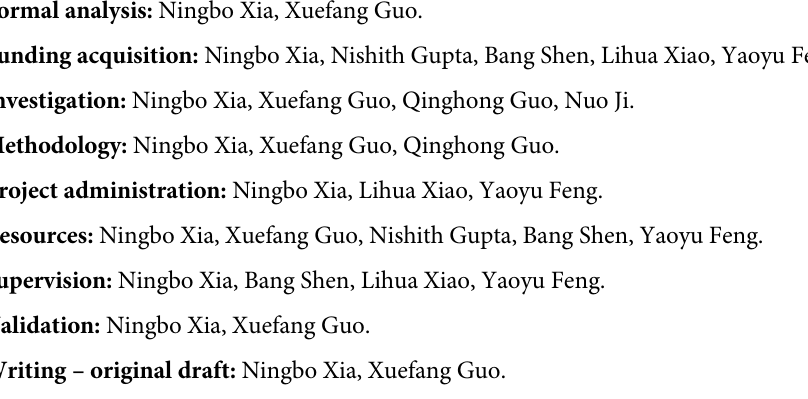
S6 Table. The metabolomics dataset used in Fig 7A–7C. S7 Table. The metabolomics dataset used in Fig 7D. S8 Table. The metabolomics dataset used in Fig 7E. S9 Table. The metabolomics dataset used in Fig 7F. S10 Table. The metabolomics dataset used in S5 Fig. S11 Table. The raw mass spectral data related to Fig 7 and S5 Fig. S12 Table. The mass spectral data used in S8